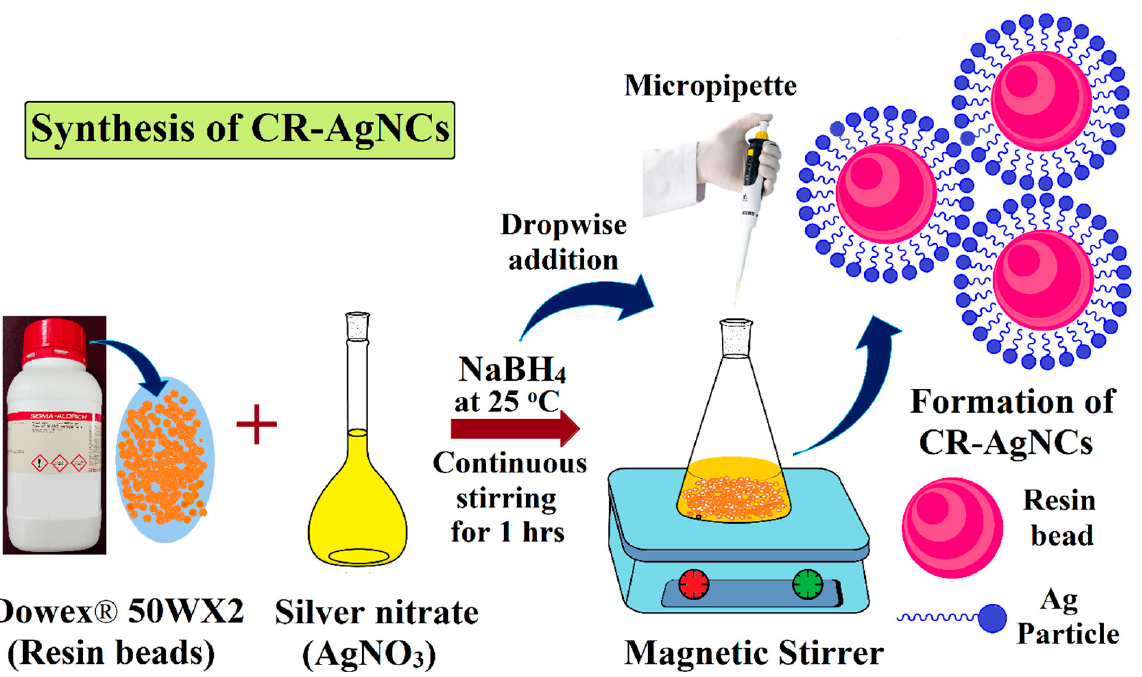
Figure 1. Schematic representation of preparation of CR-AgNCs.